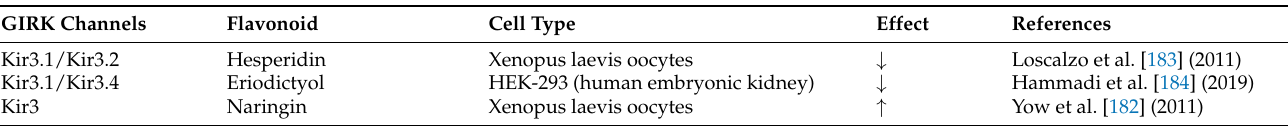
Table 5. The effects of flavonoids on the GIRK channels. The ↑ represents channel activation and ↓ denotes channel